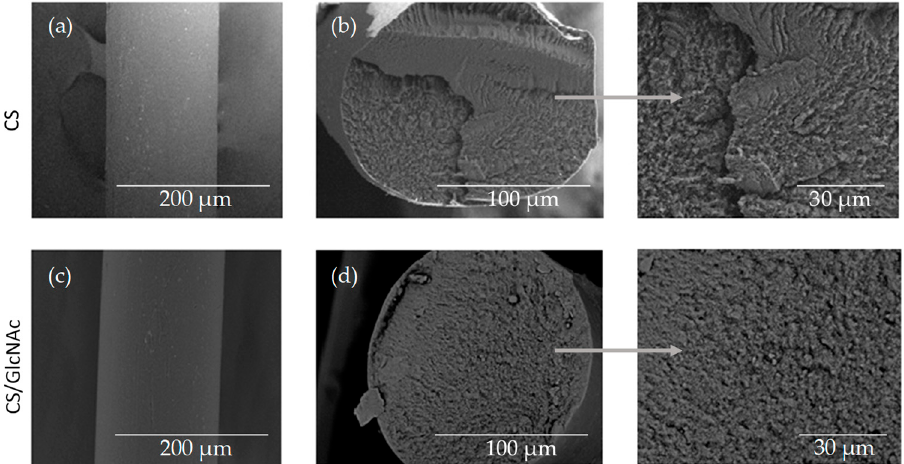
Figure 3. SEM micrographs of the surface ( a , e , and c ) and the cross-section ( b , e , and d ) morphology of the CS and CS/GlcNAc wet-spun filaments.